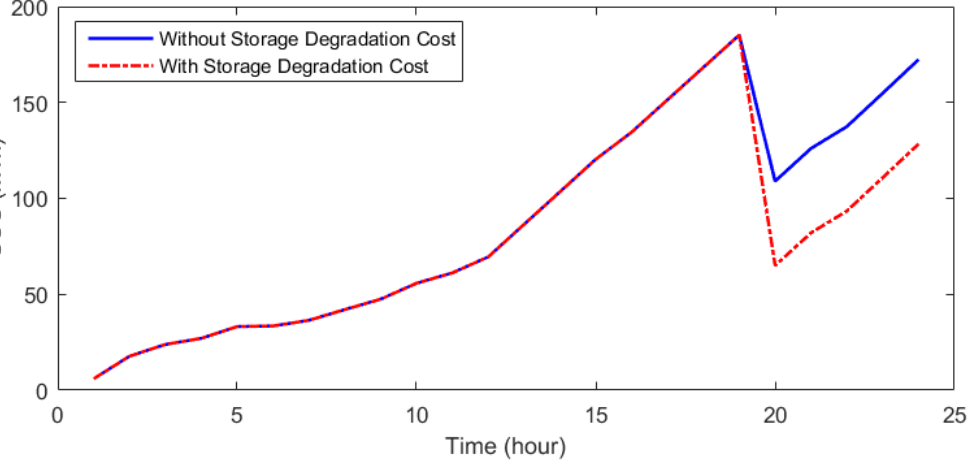
Figure 12. Battery bank energy without and with BDC in WT/Battery scheduling using the IFLA.